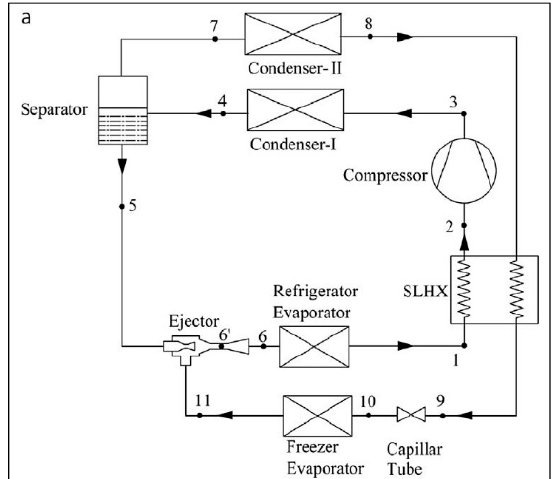
Figure 12. Variant of EERC cycle [178].